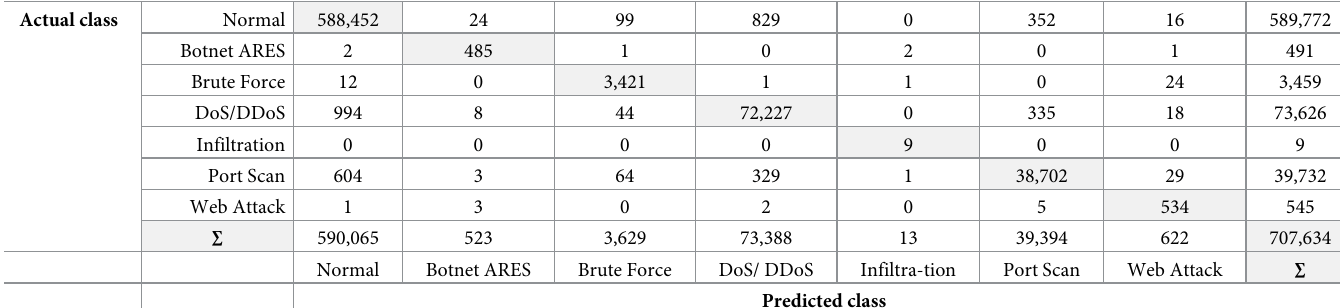
Table 8. Confusion matrix of CIC-IDS2018 dataset.